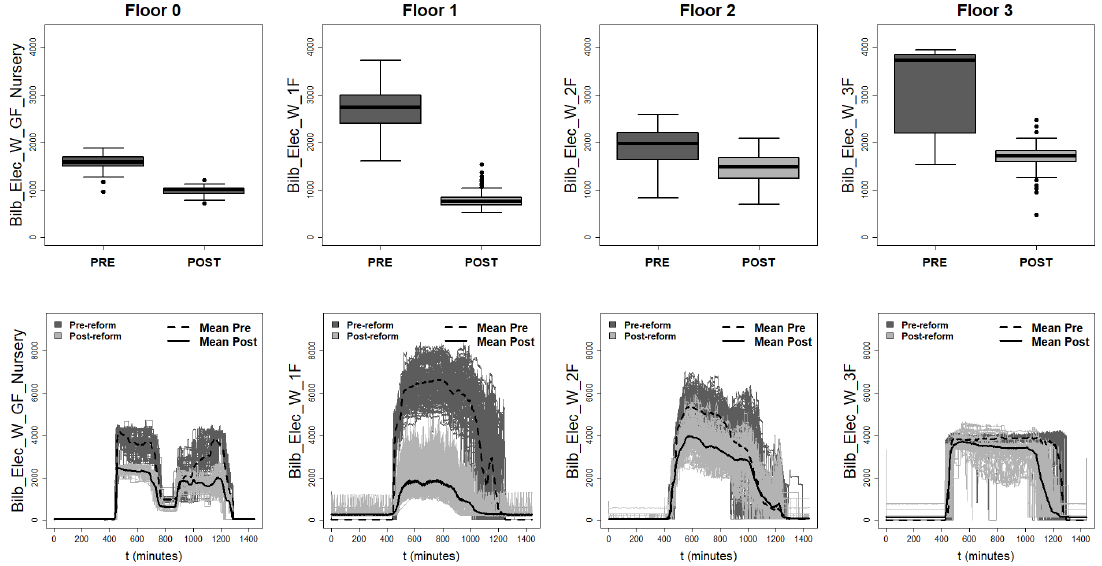
Figure 5. Analysis of the electrical lighting consumption on each floor measured in W. In the first row, the vectorial results (in form of box plots) are presented. In the second row, instead, the functional data are represented with the respective mean functions. The data are divided into winter days before and after the